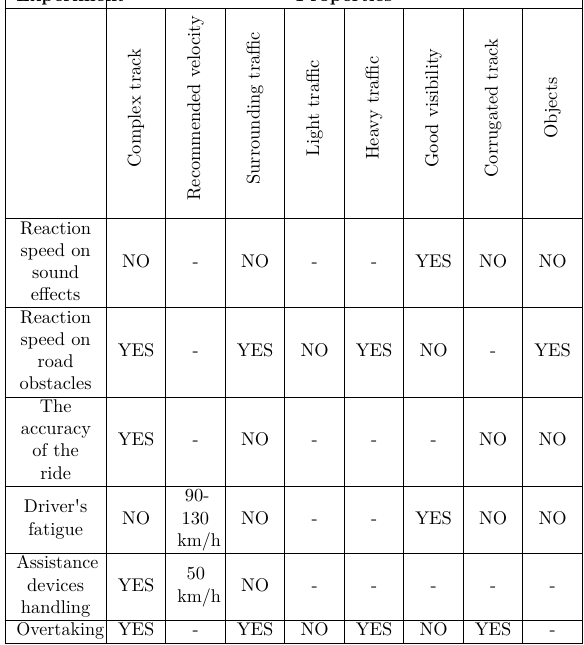
Table 1. Experimental